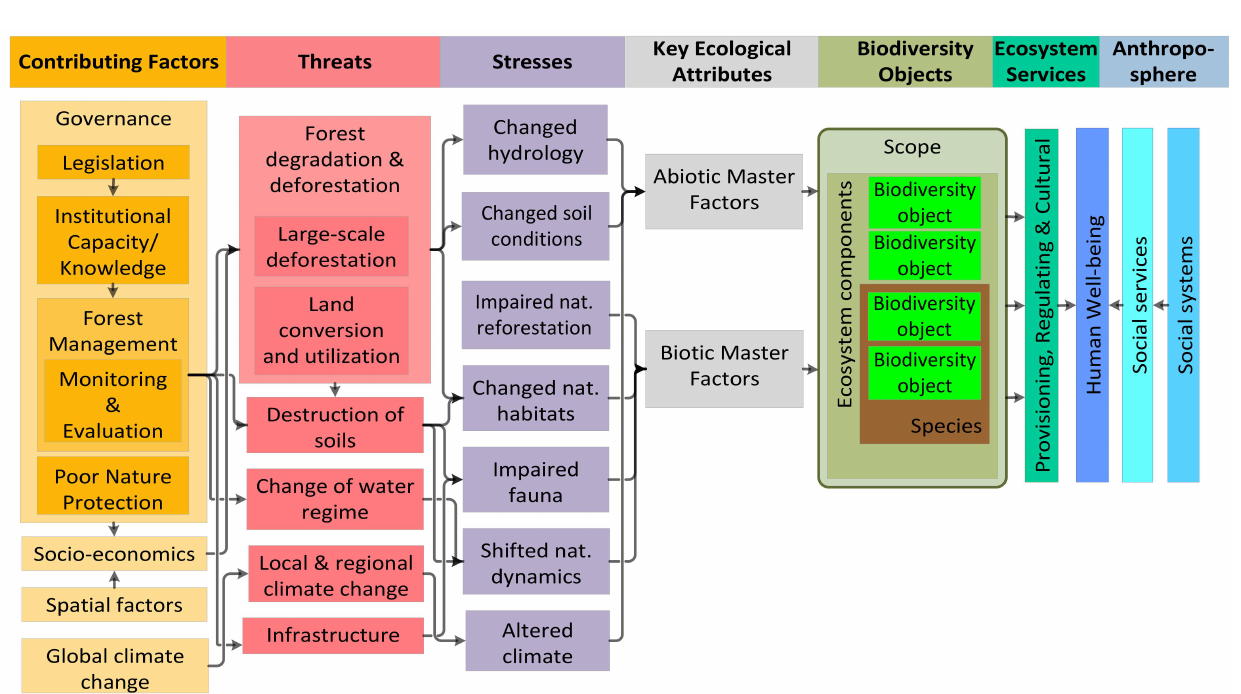
Figure 1. Generalized conceptual model with causally interlinked elements (definitions given in Table 3): Contributing fac- tors are the drivers of threats, which in turn provoke environmental stresses that degrade the key functional requirements of the ecosystems and the provision of ecosystem services essential to human well-being (left to right). Social systems provide social services that contribute to human well-being (right to